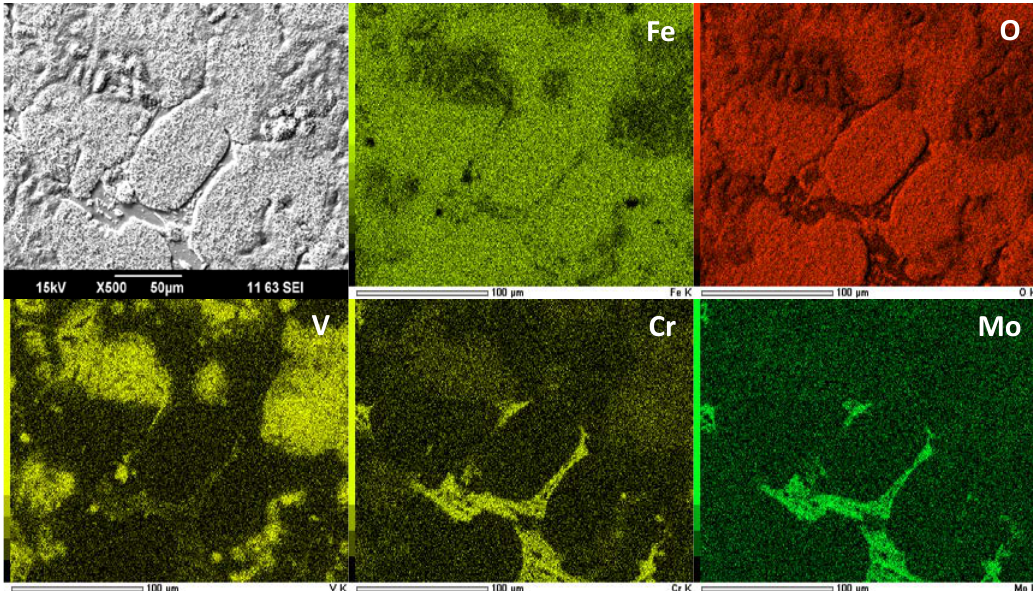
Figure 6. SEM X-ray maps of the HSS oxidized at 700 °C in humid air.